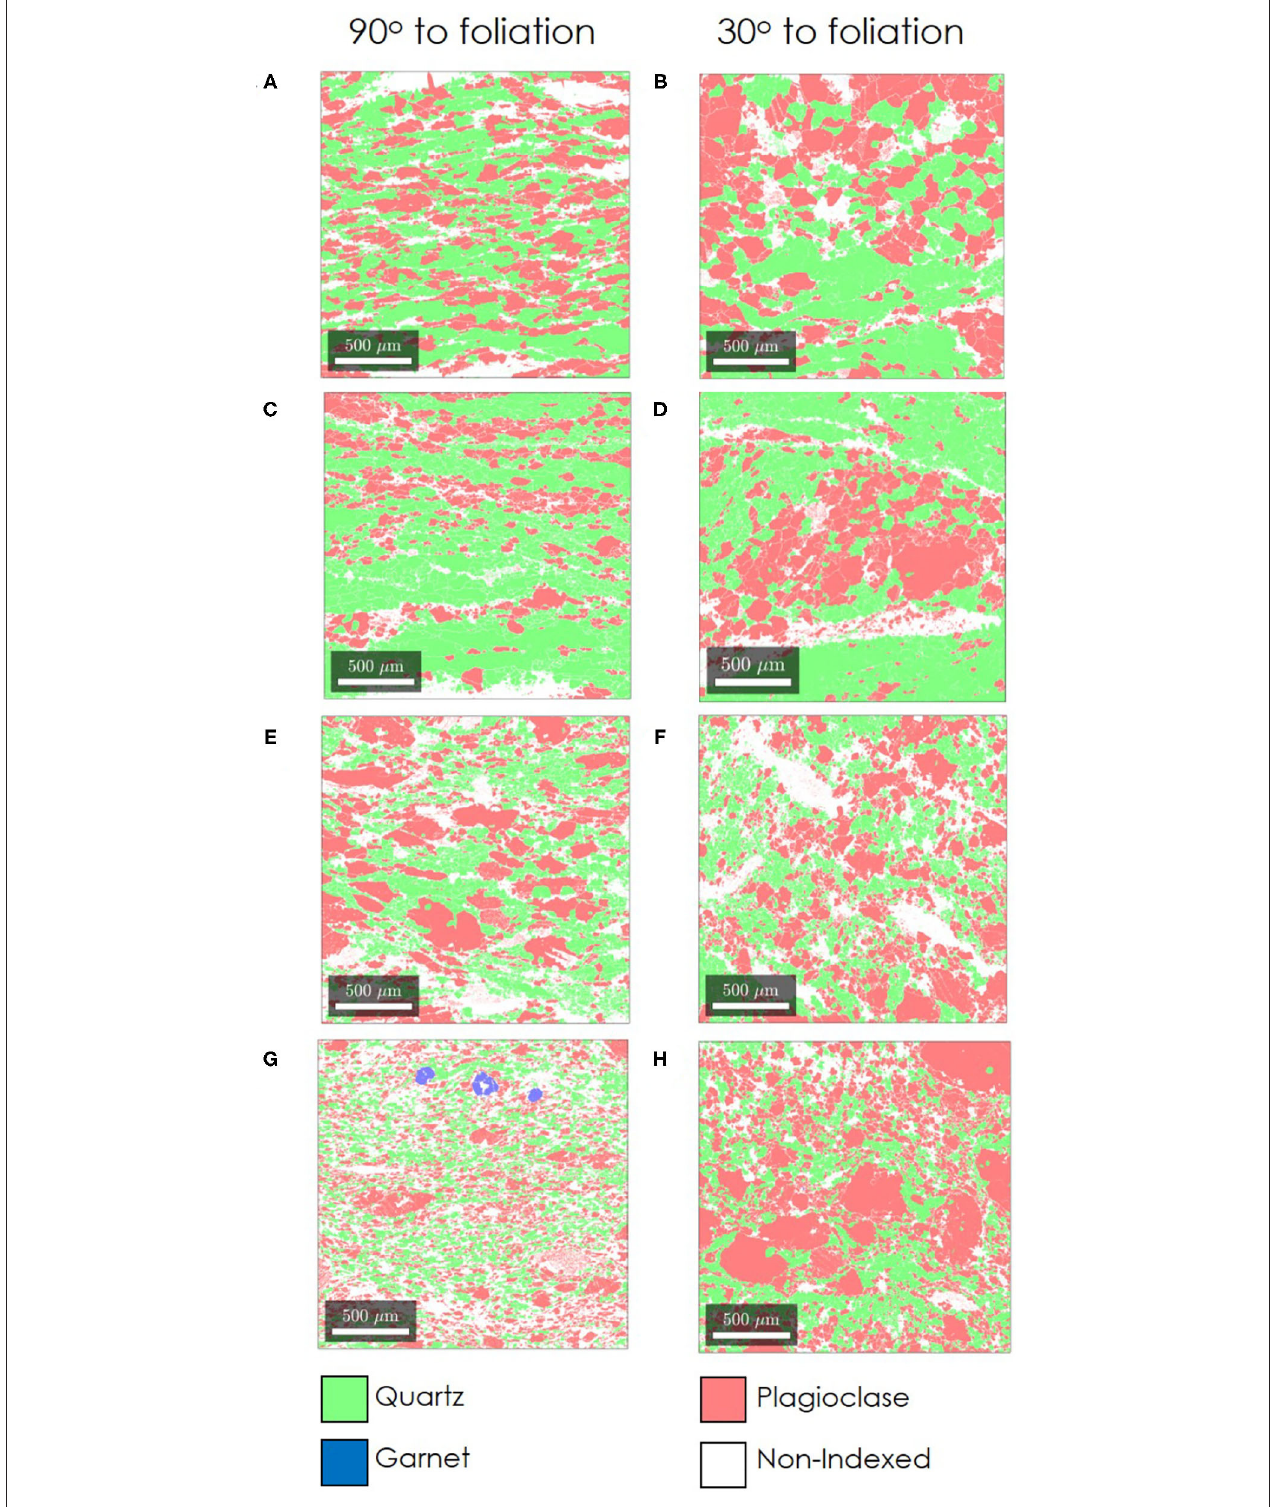
FIGURE 3 | Processed EBSD data of mineral phases distribution of (A,B) schist, (C,D) protomylonite, (E,F) mylonite, and (G,H) ultramylonite cut 90 o and 30 o to foliation, respectively.